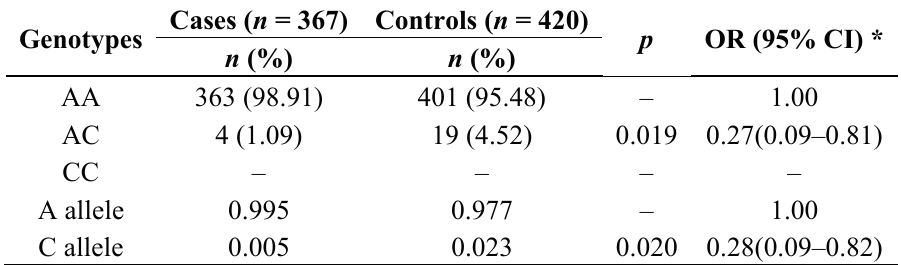
Table 2. Genotype and allele frequencies of the rs11892031 polymorphism among cases and controls and their associations with risk of bladder cancer.